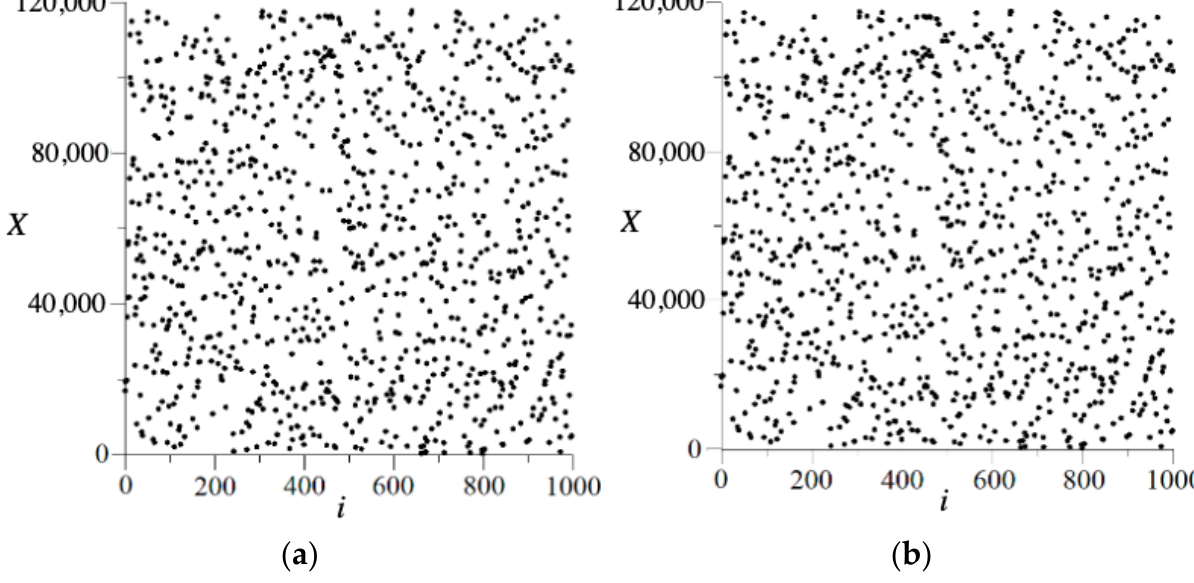
Figure 4. Current values of pseudorandom numbers X (for MAFG): ( a ) hardware model: p = 7, n = 3, A = 2 n − p = 1, a = b 0 ⊕ b 1 ⊕ b 2 , X (0) = 1; ( b ) abstract model: p = 7, a = b 0 ⊕ b 1 ⊕ b 2 , X (0) = 1.